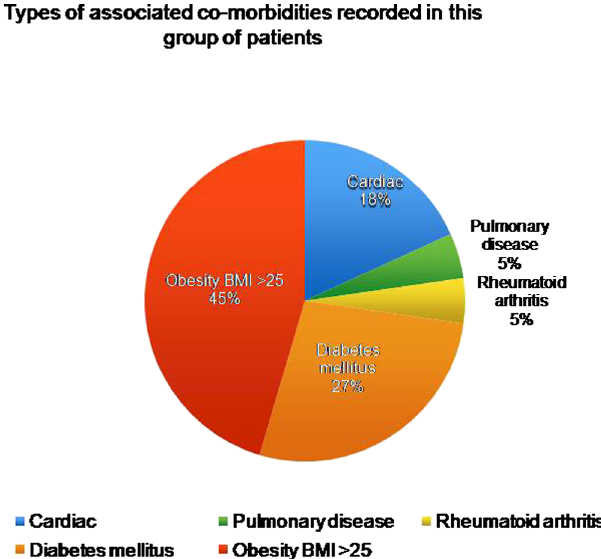
Figure 5. Percentage of various general health problems and co-morbidities found in this cohort of